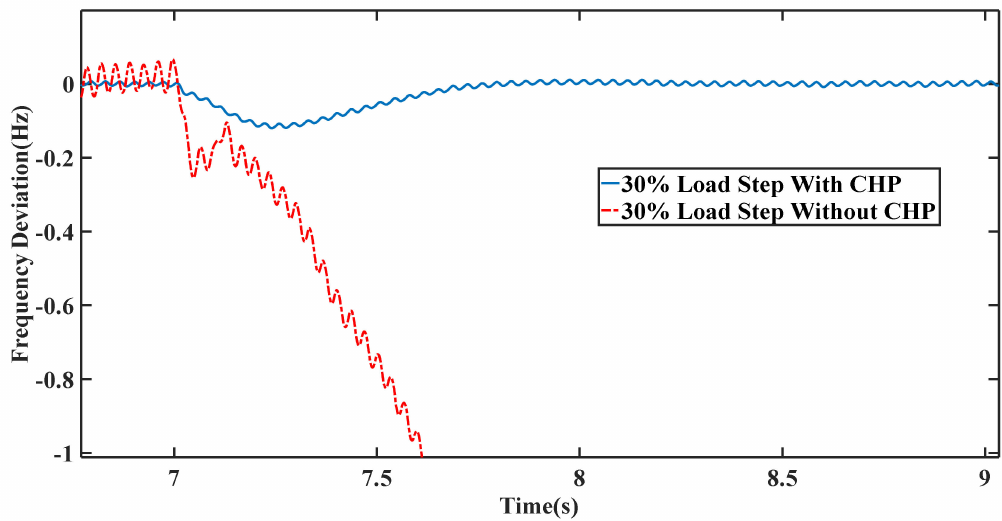
Figure 13. Excessive frequency excursion due to lack of CHP collaboration in islanded